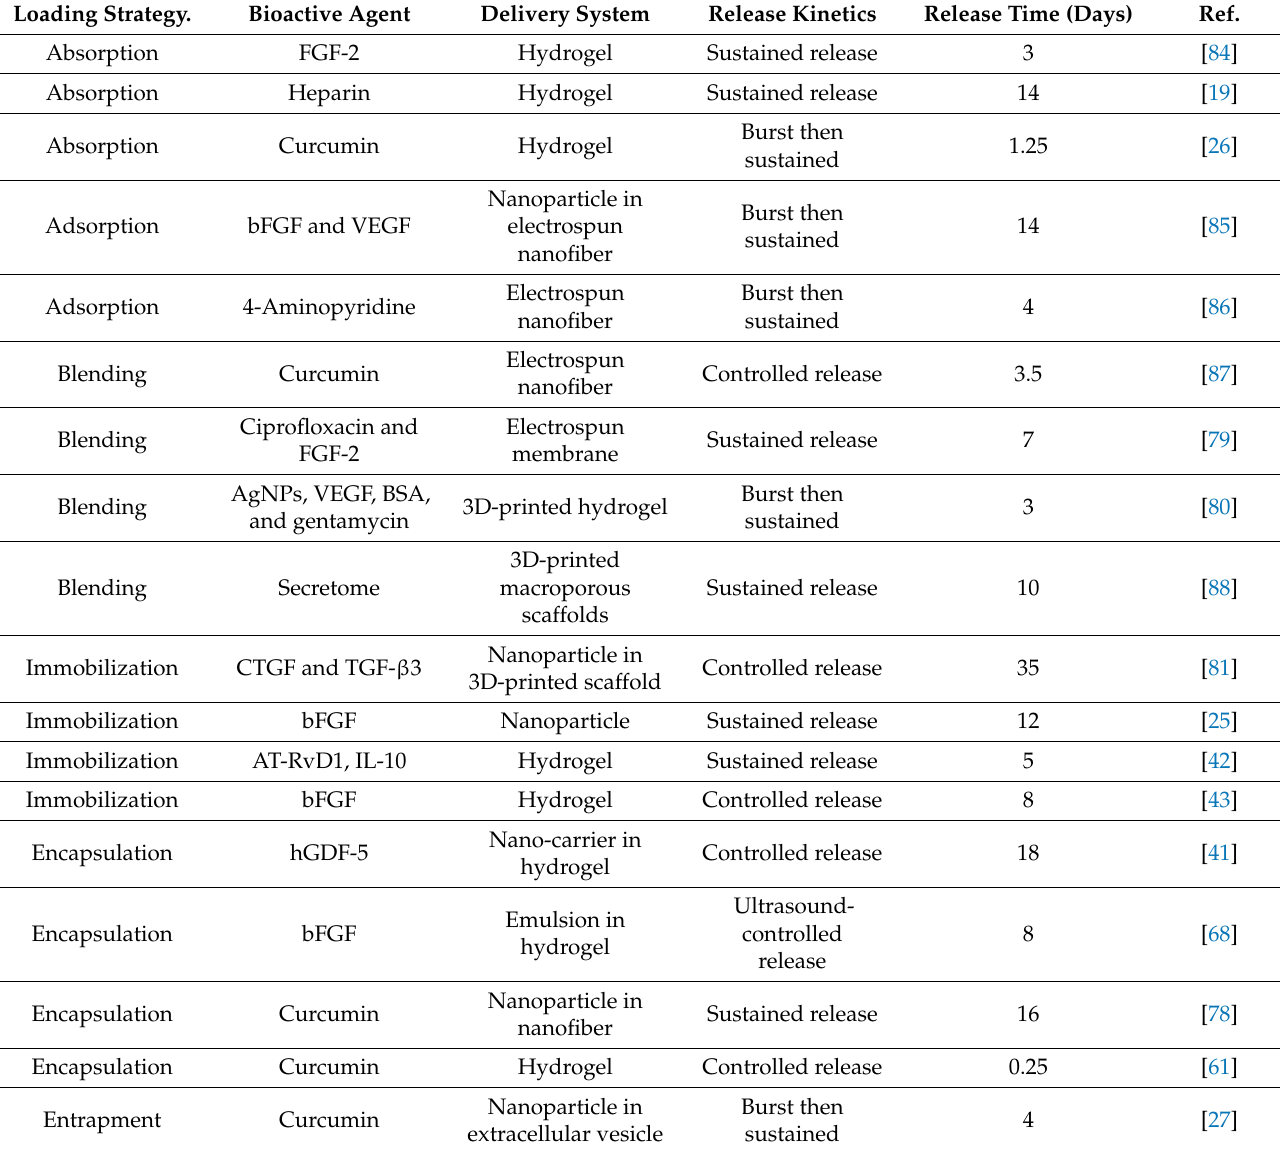
Table 1. List of multiple loading strategies utilized in bioactive agent-based delivery systems for regenerative therapy with varied release